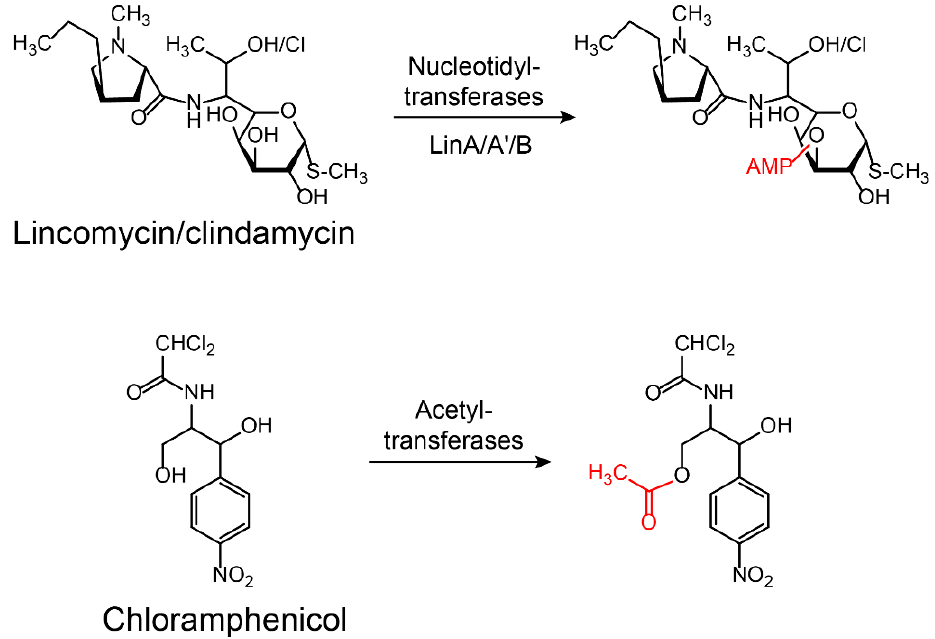
Figure 5. Inactivation of lincomycin/clindamycin and chloramphenicol by nucleotidyltransferases or acetyltransferases. LinA/A’/B: Lincomycin nucleotidyltransferases A/A’/B.